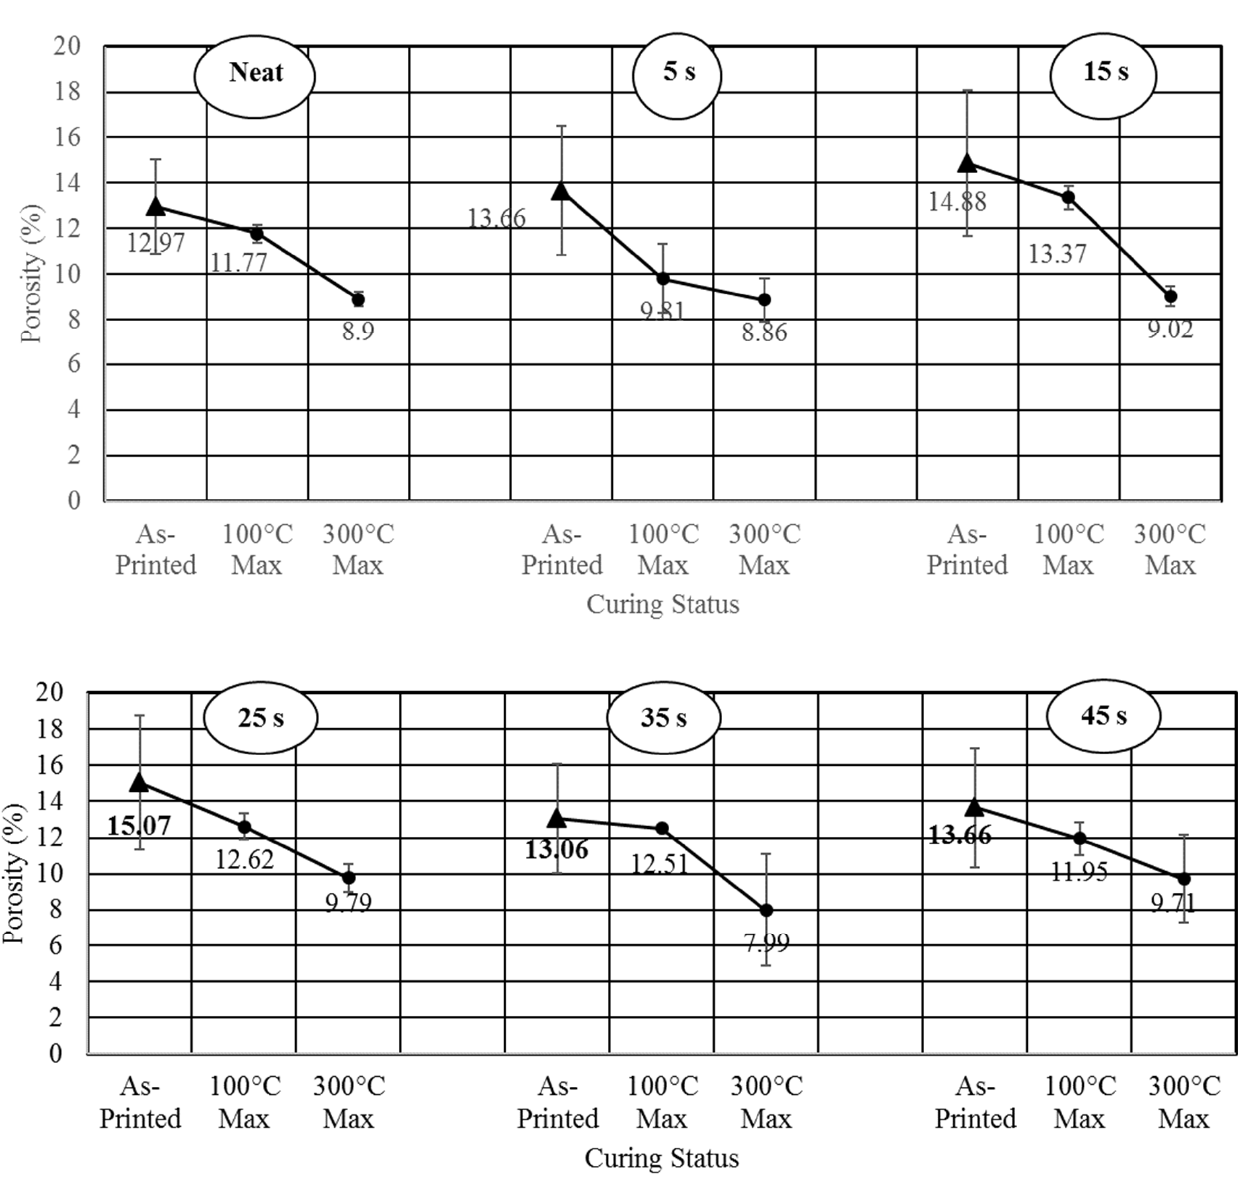
Figure 7. Carbonation duration (circled value) and curing (post-heat treatment) effects on polymer porosity. The error bars are plotted for each porosity. The error bars are plotted for each point.